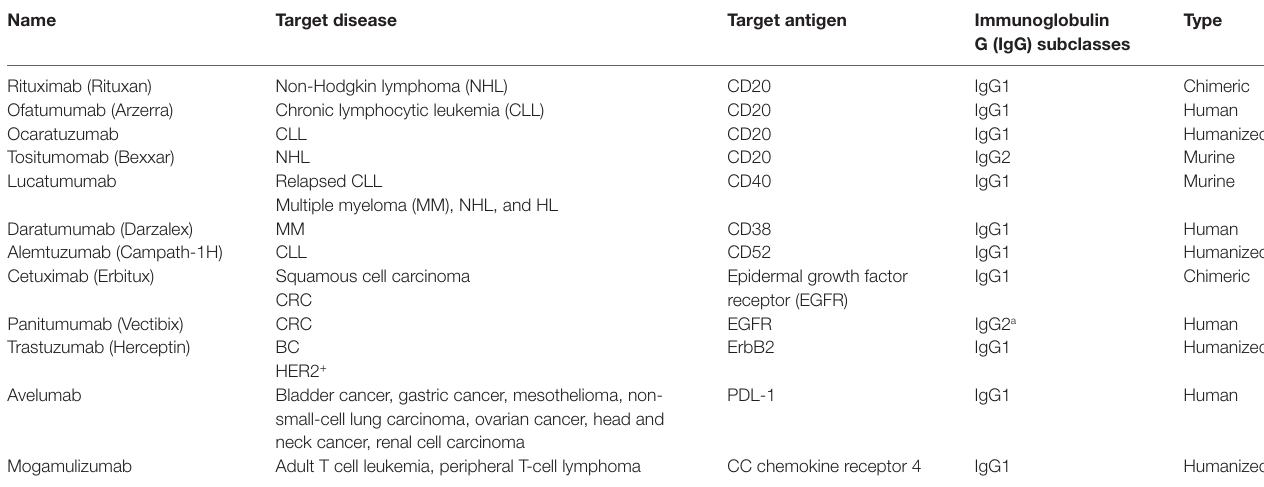
TABLe 1 | Summary of therapeutic monoclonal antibodies (mAbs) with proved antibody-dependent cellular cytotoxicity (ADCC)